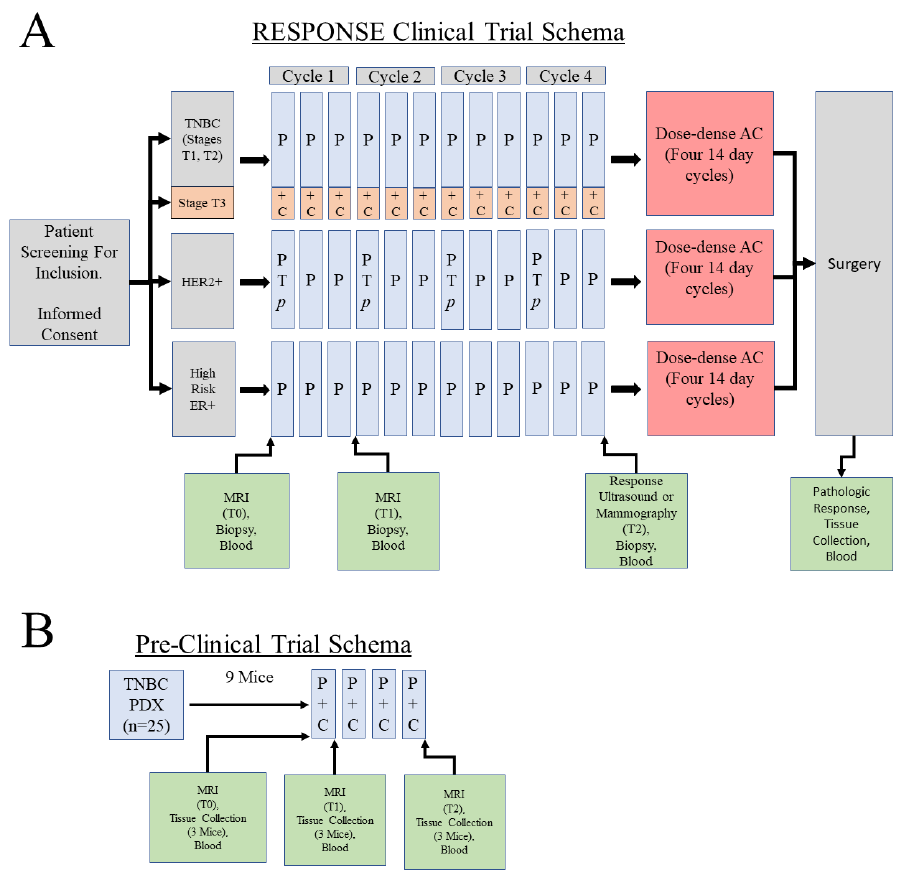
Figure 2. Co-clinical trial design. ( A ) Overall RESPONSE clinical trial schema. For the purposes of this study, only the Stage T3 TNBC portion of the trial will be used in which patients will receive